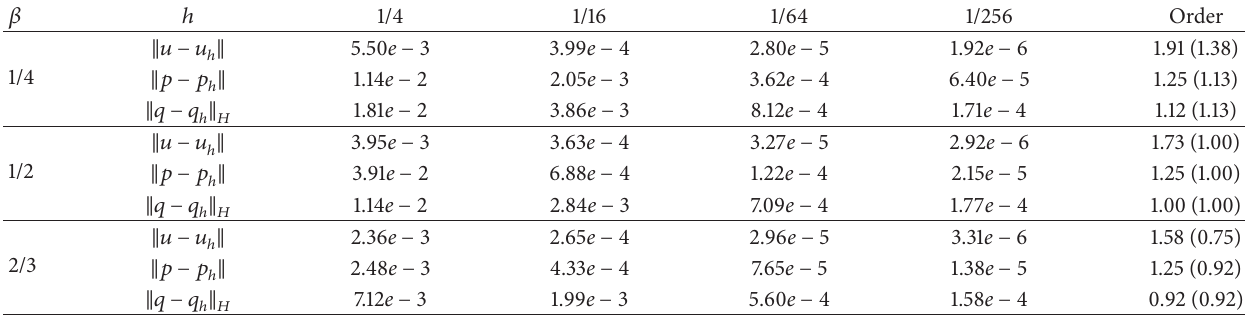
Table 8: Numerical result of Example 4 on a uniform mesh of size ℎ for 𝑘 = 2